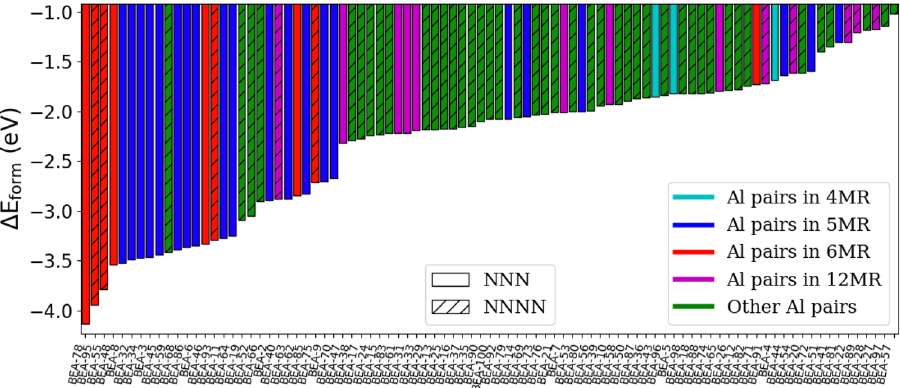
Fig. 6 Formation energy of Pd + 2 on BEA. Each bar represents unique Al locations. Color coding refers to the type of Al pairs in the zeolite matrix. Patterned bars refer to Al pairs in NNNN positions while solid bars refer to Al pairs in NNN positions. The four most stable sites are illustrated in Fig. 5.